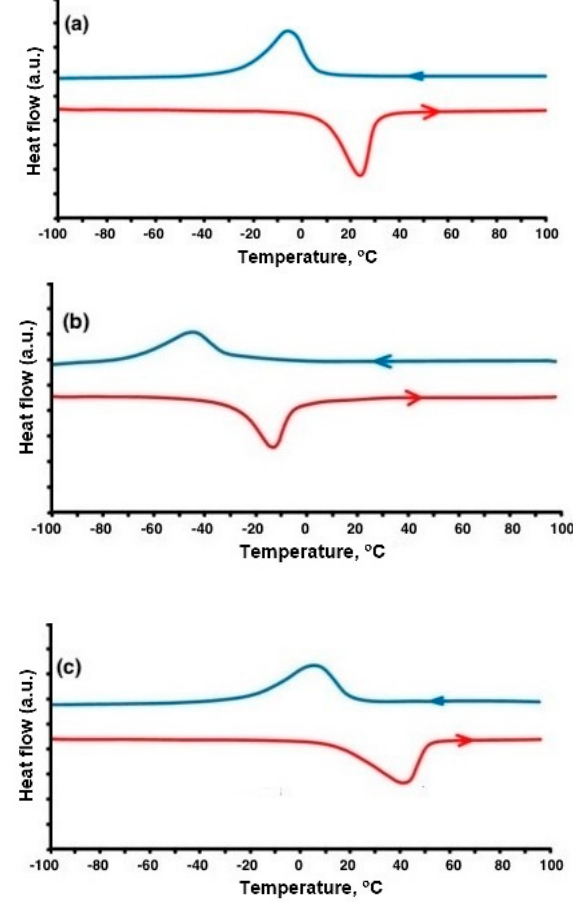
Figure 4. DSC curves for samples made from NiTi 50.7 powder with parameter sets 2 with VED = 173.6 J/mm 3 ( a ), parameter set 4 with VED = 130.2 J/mm 3 ( b ), parameter set 4_2 with VED = 130.2 × 2 J/mm 3 ( c ) according to Tables 2 and 3.